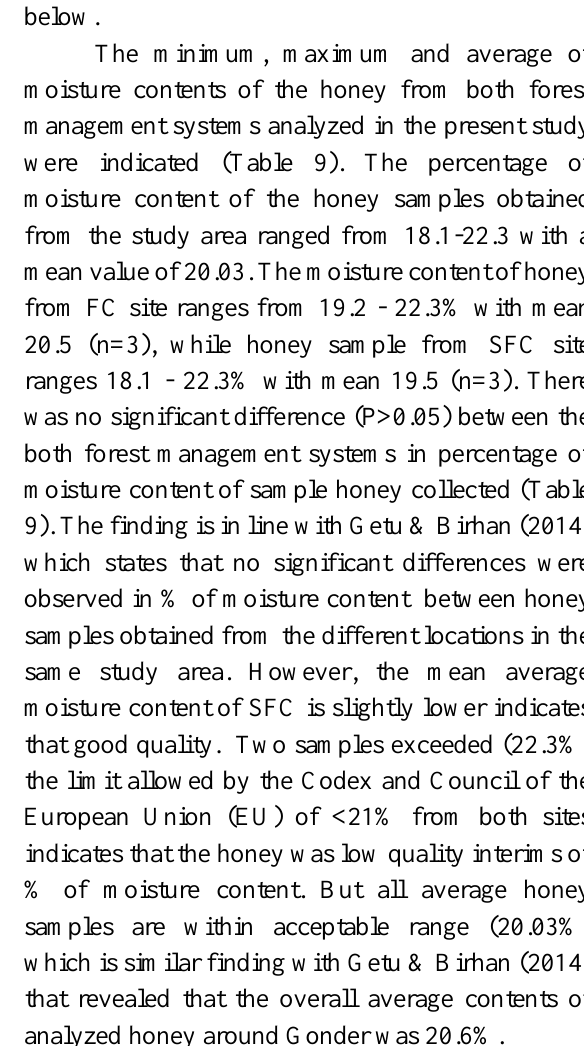
Table 8 Summary of physicochemical properties of honey from Gera district both Forest types